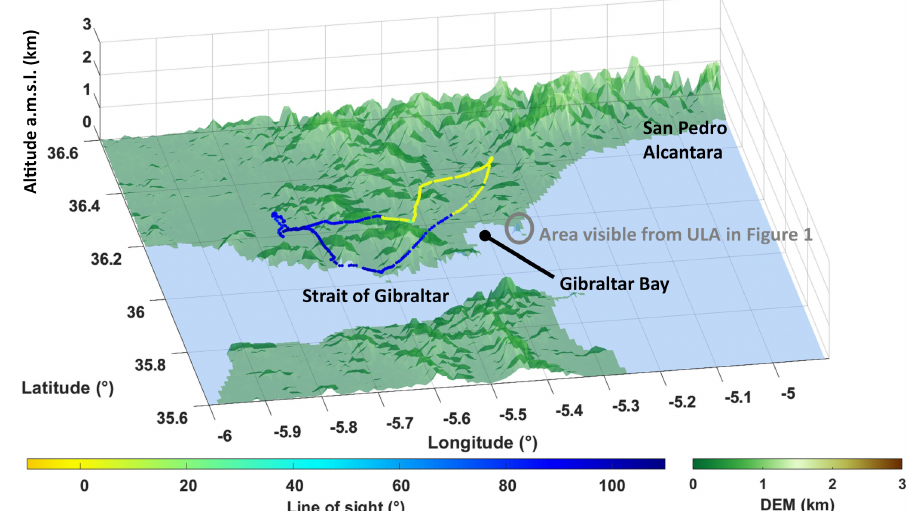
Figure 2. Flight plan of the ULA above the Strait of Gibraltar on 13 August 2011. The colour bar represents the angle of the line of sight (with respect to the true horizon). The broken blue line corresponds to both the ascent and the descent and the broken yellow line to the ULA’s flight ceiling. The view from the ULA in Fig. 1 is also highlighted. DEM stands for digital elevation model.